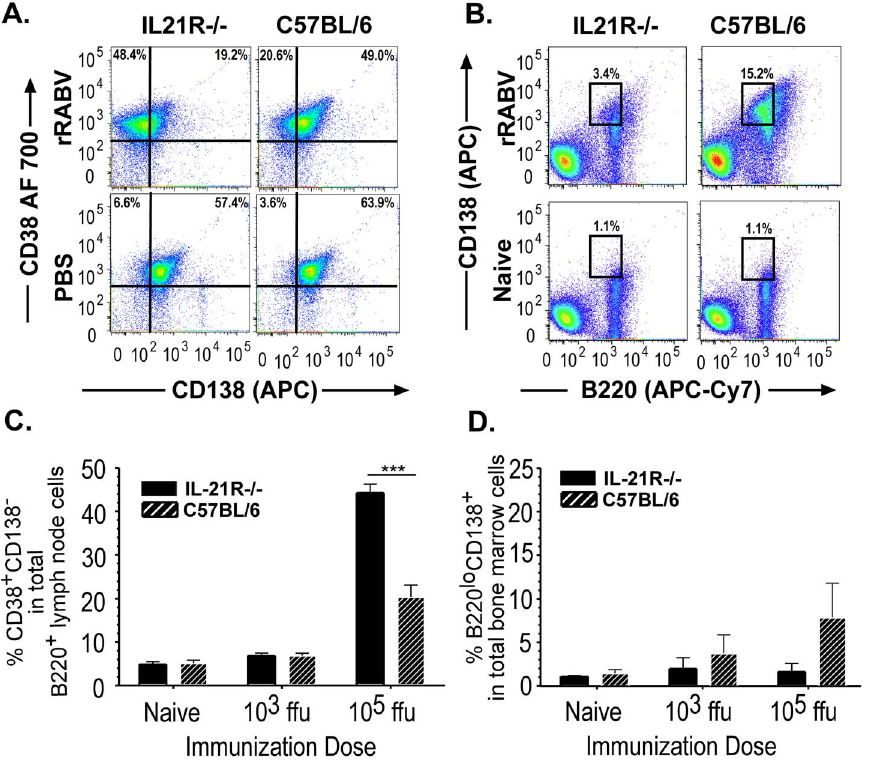
Figure 6. IL-21 is dispensable for memory B cells but required for optimal PC formation. IL-21R 2 / 2 or C57BL/6 mice were immunized i.m. with a single dose of 10 3 or 10 5 ffu/mouse with rRABV and memory B cell or PC populations were analyzed 7 or 14 days post-immunization, respectively. A, B220 + B cells were gated from the total live draining lymph node cell population as described in Figure 5. Representative gating strategy from IL-21R 2 / 2 or C57BL/6 mice immunized with rRABV or PBS to determine memory B cells (B220 + CD38 + CD138 2 ) from total B220 + B cells in the draining lymph node. B, Representative gating strategy from IL-21R 2 / 2 or C57BL/6 mice immunized with rRABV or PBS to identify PCs (B220 lo CD138 + ) from the total cells in the bone marrow. C, Percentage of B cells displaying a memory B cell phenotype in the lymph node was determined in IL-21R 2 / 2 or C57BL/6 mice immunized with 10 3 or 10 5 ffu/mouse at 7 days post-immunization with rRABV or PBS. D, Percentage of PCs in the BM cell population was determined from IL-21R 2 / 2 or C57BL/6 mice immunized with 10 3 or 10 5 ffu/mouse at 14 days post-immunization with rRABV or PBS. Statistical difference in B cell data between two groups of data was determined using an unpaired, two-tailed t test and data is presented at the mean 6 SEM. *p , 0.05, **p=0.01–0.001, ***p # 0.001; (N=5 mice per group).